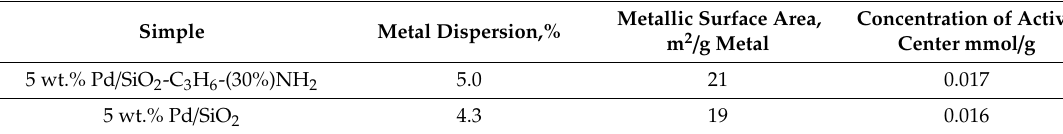
Table 1. Hydrogen pulse chemisorption data.